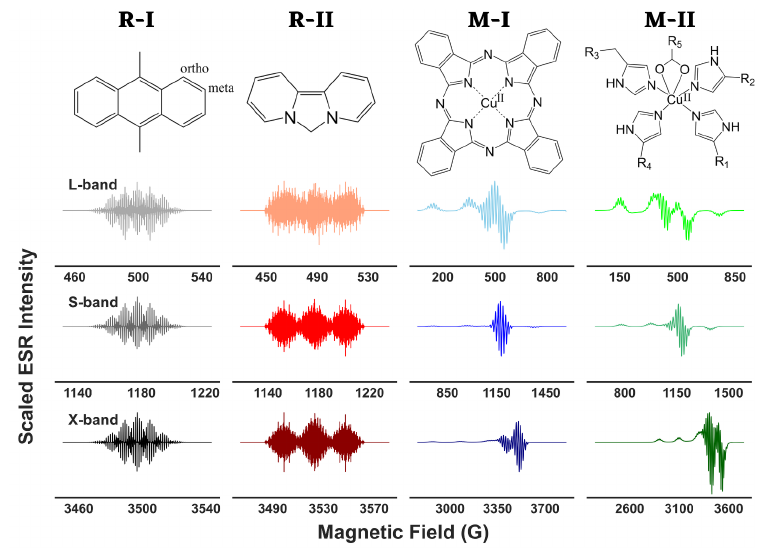
Figure 1. The organic radicals (R-I, R-II) and metal–ligand adducts (M-I, M-II) used in this work along with their simulated ESR spectra at L-, S-, and X-band